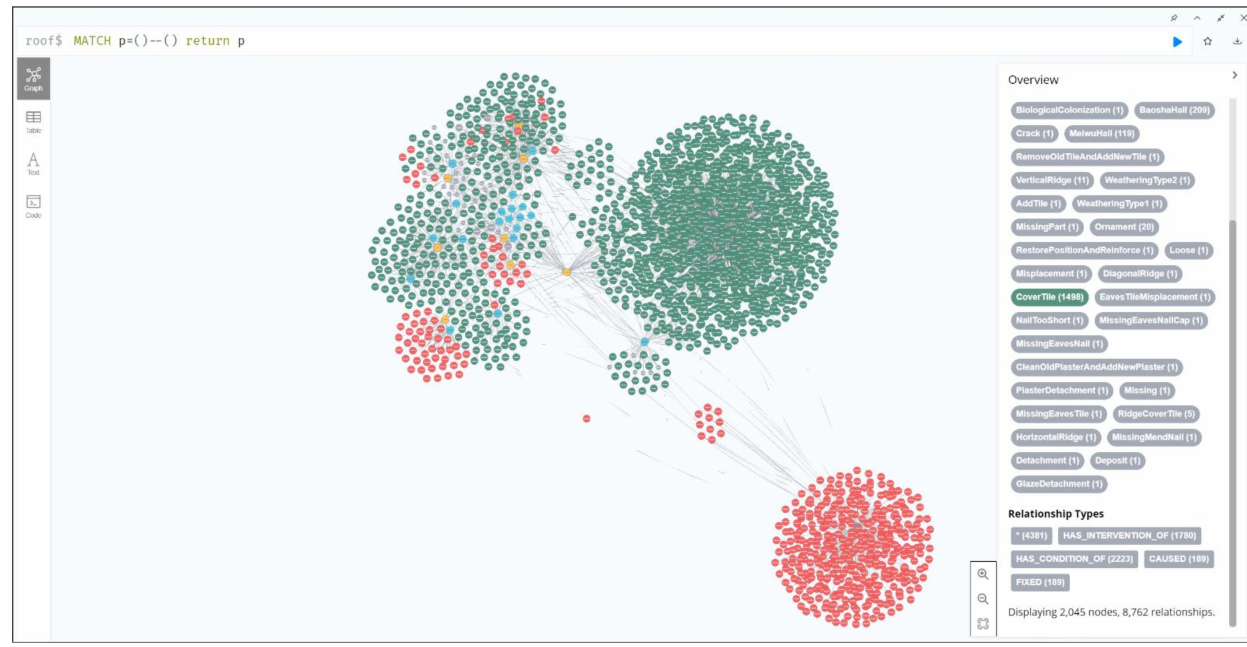
Figure 11. The comparisons of the gutter and the falling watershed in similar aspects.